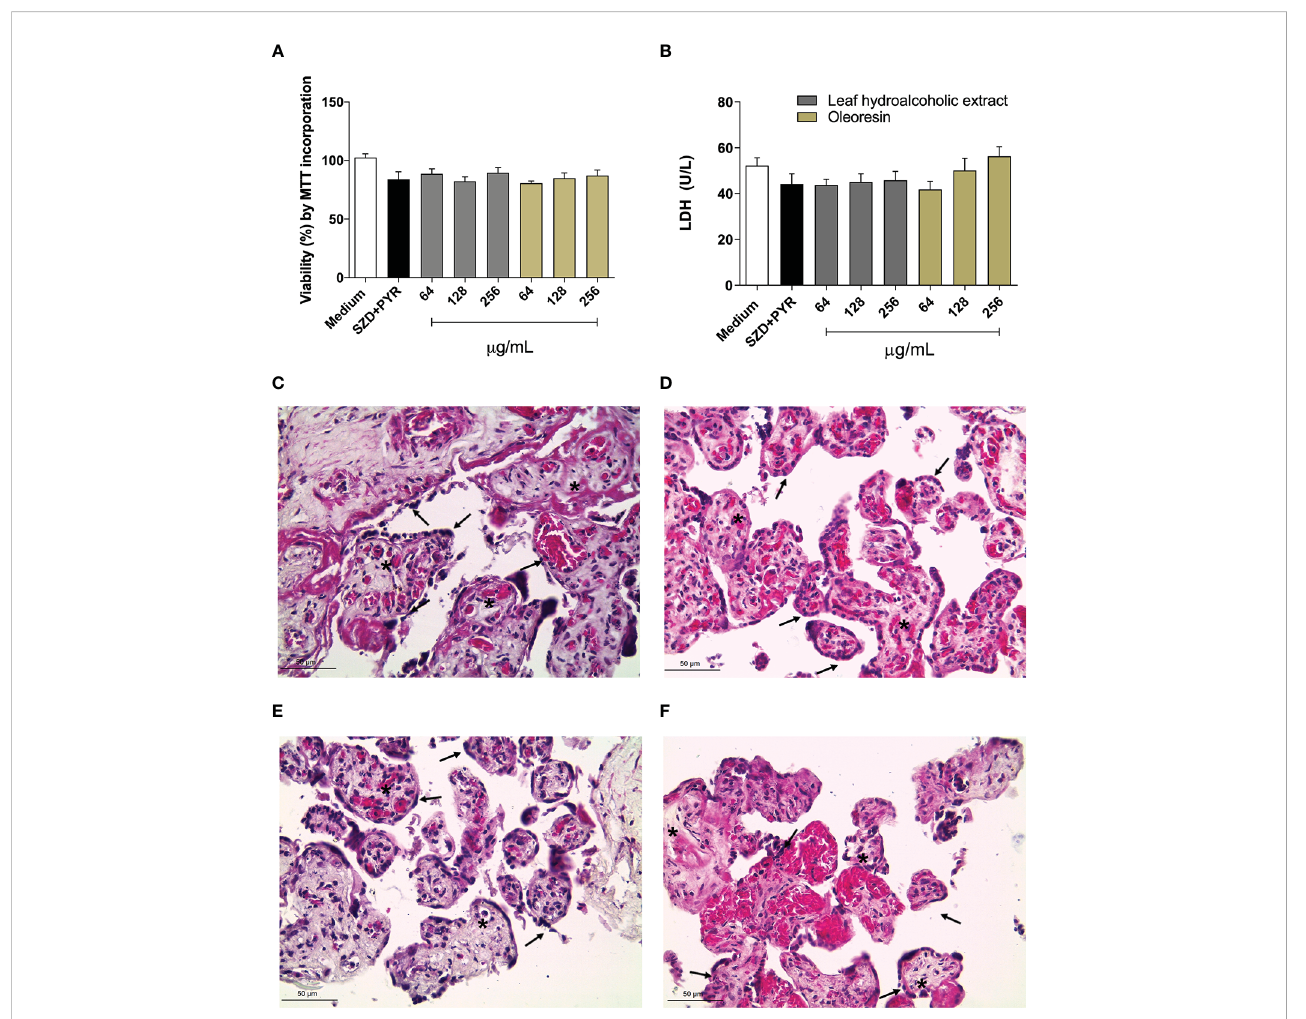
FIGURE 9 Viability of human villous explants. The villous explants were treated for 24 h with hydroalcoholic extract or oleoresin from C . multijuga , SDZ+PYR or culture medium alone (medium). (A) Tissue viability is shown in percentages (% viability by incorporation of MTT). (B) Supernatants were collected and used to measure LDH levels (U/L). Representative images of villi incubated with (C) culture medium alone, (D) SDZ+PYR, 256 µg/mL hydroalcoholic extract (E) , 256 µg/mL oleoresin (F) . Data are expressed as means ± standard deviation of two experiments performed in six replicates. Signi fi cant differences detected by One-way ANOVA, Bonferroni ’ s multiple comparisons post-test (statistically signi fi cant when P < 0.05). Hematoxylin-eosin (HE) stained histological sections show syncytiotrophoblast cells (black arrows) and mesenchyme (*). Scale bar: 50